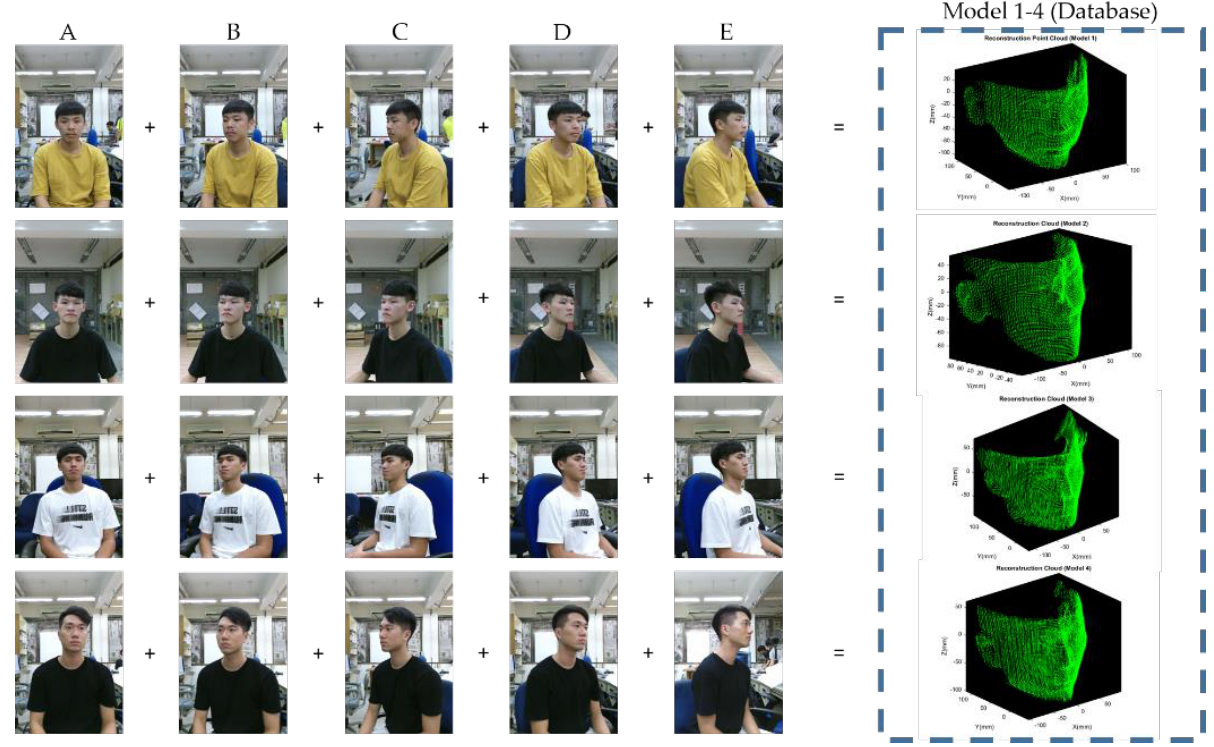
Figure 20. Schematic illustration of model point cloud reconstruction.